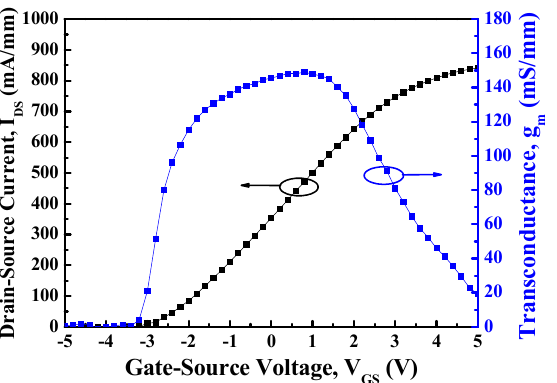
Figure 6. Under the operation of drain−source voltage of 10 V, drain−source current and extrinsic transconductance as a function of gate−source voltage of MOSHEMTs with multiple-mesa-fin-channel array.